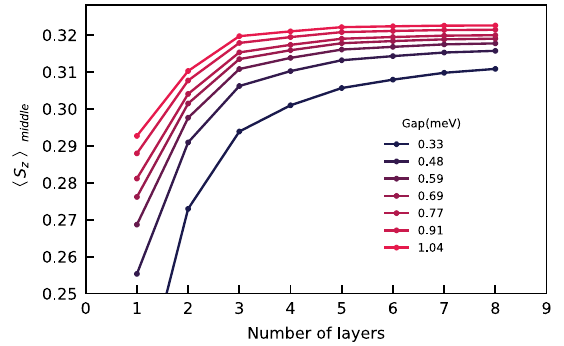
FIG. 4. Theoretical modeling. Calculated magnetic-order param- eter at the middle of the slab, h S z i , as a function of the layer P middle ⃗ S ⃗ S þ number from the model Hamiltonian H ¼ ð J= 2 Þ li · lj l;ij P P ⃗ S ⃗ S S z S z þ ð J = 2 Þ T ¼ 80 K with exchange Δ c li · l 0 j at l;ij ll 0 ;ij li lj terms J ¼ 60 meV and J c ¼ 16 . 4 μ eV. Different curves corre- spond to different anisotropic exchange Δ strengths, and the consequent gap sizes are used as an